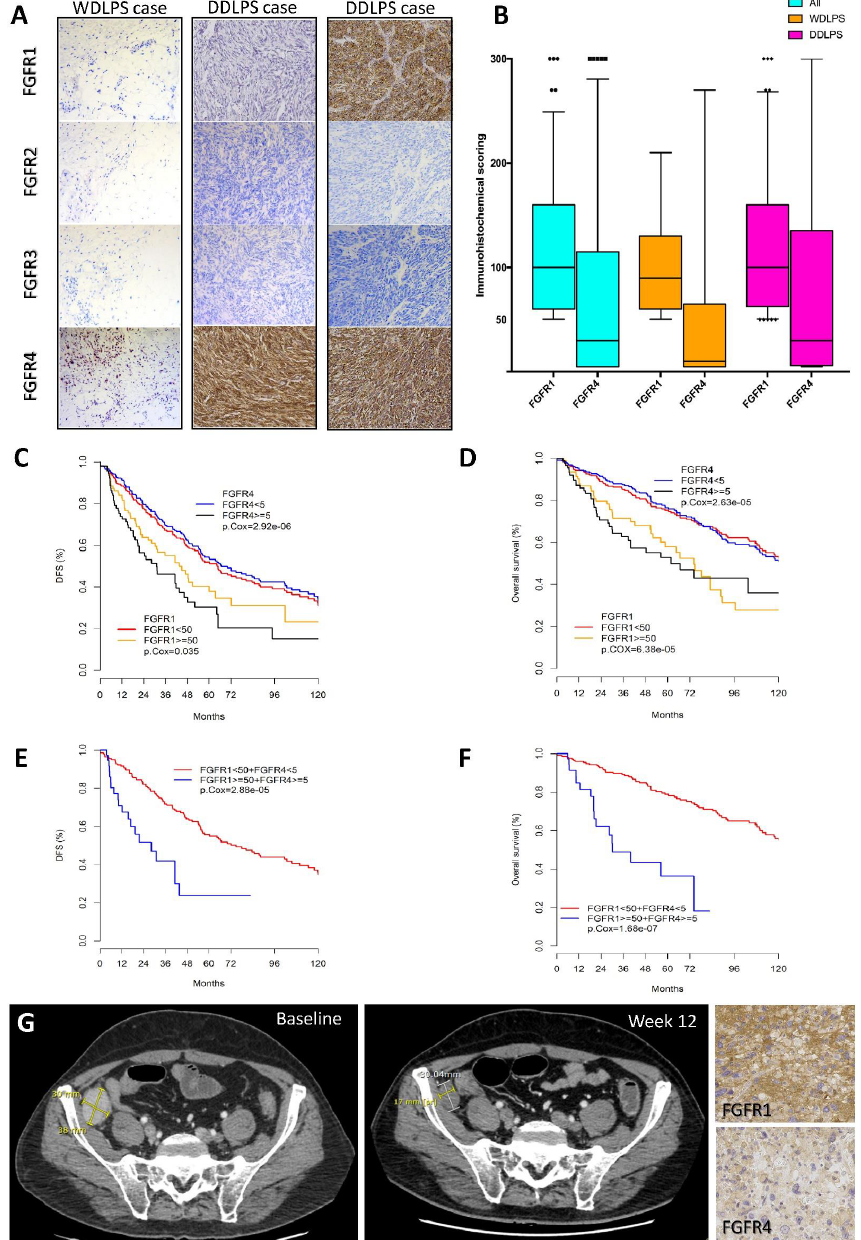
Figure 1. FGFR1 and FGFR4 expression in WDLPS / DDLPS clinical tumor samples and prognostic values. ( A , B ) Immunohistochemical analysis in our series of 418 tumors. ( A ) Representative illustrations of WDLPS cases positive for FGFR4 (left-hand side); DDLPS cases positive for FGFR4 (middle column) and DDLPS cases positive for both FGFR1 and FGFR4 expression (right-hand side) (localization: membrane and cytoplasm, magnification × 100). ( B ) Box plot showing the distribution of IHC scores for the overexpressing cases* for FGFR1 and FGFR4 in the WDLPS and DDLPS cases of the IHC cohort. ( C–F ) Prognostic value of FGFR1 and FGFR4 expression in our cohort of 358 WDLPS / DDLPS patients: Kaplan-Meier survival analyses of FGFR1 and / or FGFR4 expression shows correlation between FGFR1 and / or FGFR4 expression and disease-free survival (DFS, C and E) and overall survival (OS, D and F). ( G ) E ff ects of treatment with the erdafitinib pan-FGFR inhibitor (JNJ42756493) in a patient with refractory DDLPS. CT scan images of a 57-year-old male patient with a refractory DDLPS before and after erdafitinib treatment. The patient was resistant to doxorubicin, regorafenib, high-dose ifosfamide, trabectedin and presented a stable disease during 12 weeks (according to the RECIST criteria) under erdafitinib treatment. This tumor co-expressed FGFR1 (score 120) and FGFR4 (score